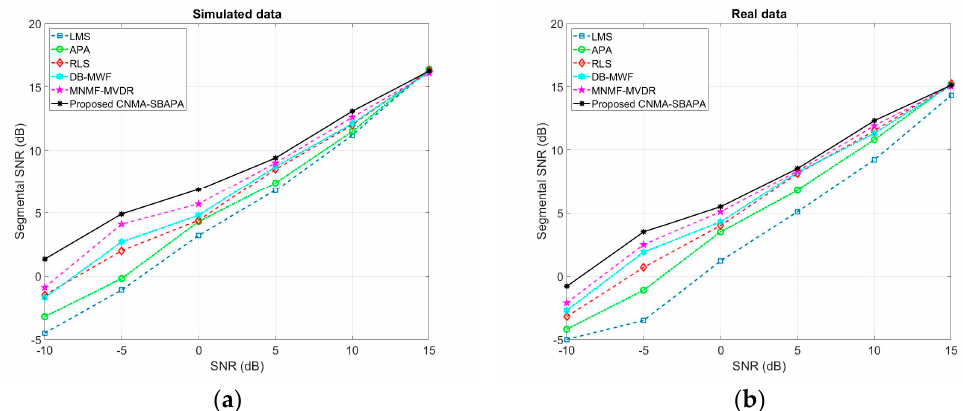
Figure 12. The segmental signal-to-noise ratio (SegSNR) comparison between the proposed CNMA-SBAPA, LMS, traditional APA, RLS, DB-MWF, and MNMF-MVDR methods on ( a ) simulated and ( b ) real data for white noise.